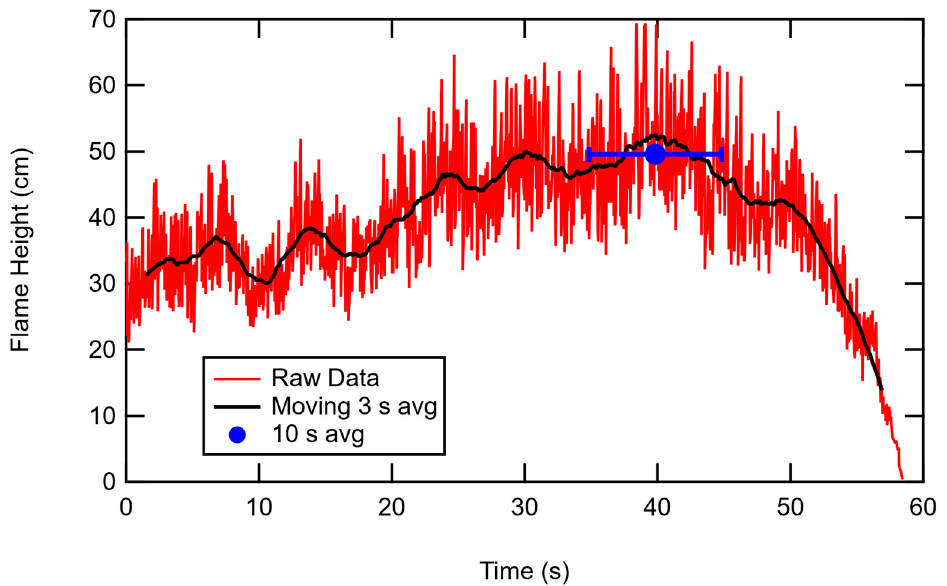
Figure 4. Flame height vs. time for two pads with no horizontal or vertical spacing, showing the 3 s moving average as well as the average flame height at the maximum filtered flame height.